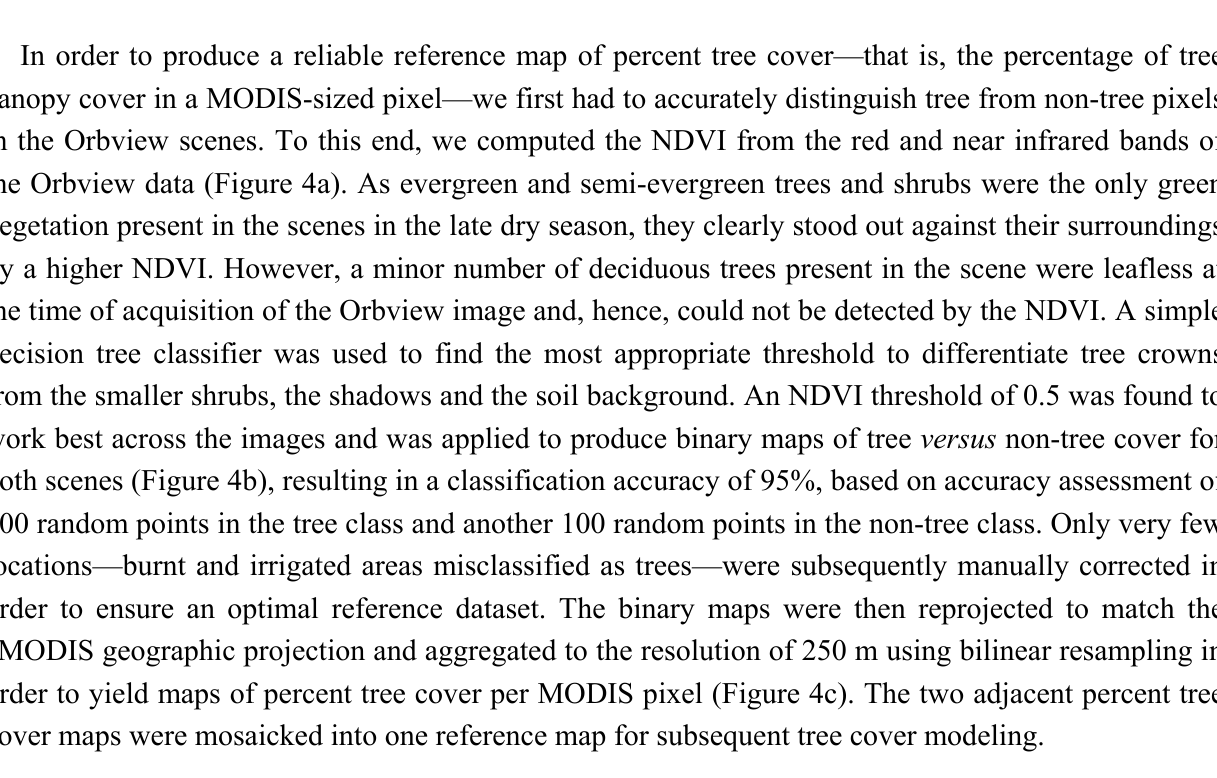
Figure 4. 1 km 2 subset of ( a ) false-color composite of Orbview image, ( b ) extracted tree canopy cover superimposed on Orbview image, and ( c ) percent tree cover reference data at 250 m resolution, aggregated from the extracted tree canopy cover (superimposed). Lowest percent tree cover is shown in light yellow, highest in dark green tones, see full color legend in figure in Section